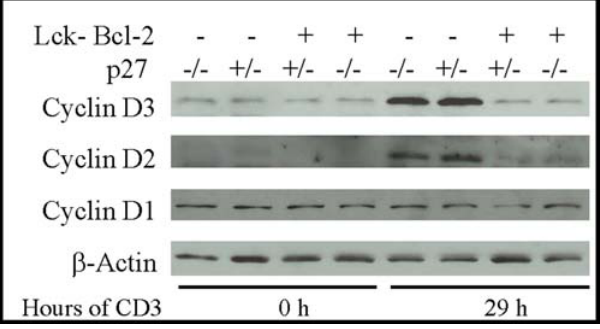
Figure 6. Bcl-2 delays the upregulation of Cyclins D2 and D3 independent of p27. T cells from mice of the indicated genotypes were purified and activated with immobilized anti-CD3 antibody prior to harvesting for immunoblot analysis at the time indicated. Immunoblots for total Cyclin D1, Cyclin D2, Cyclin D3, and Actin as a loading control are